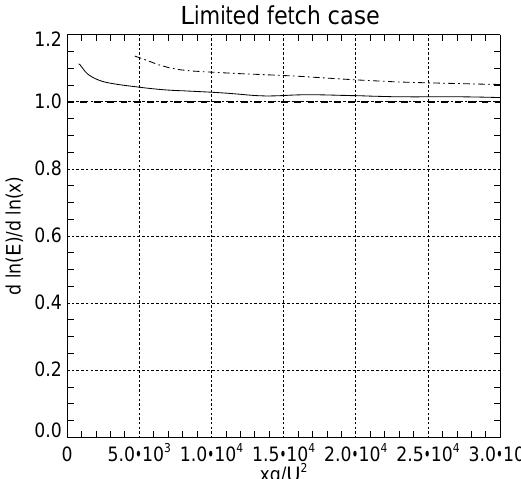
Figure 13. Energy local power function index p = dln E function of dimensionless fetch xg/U 2 for the fetch limited case: wind speed U = 10ms − 1 – solid line; wind speed U = 5ms − 1 – dash-dotted line. Theoretical value of self-similar index p = 1 – thick horizontal dashed line.